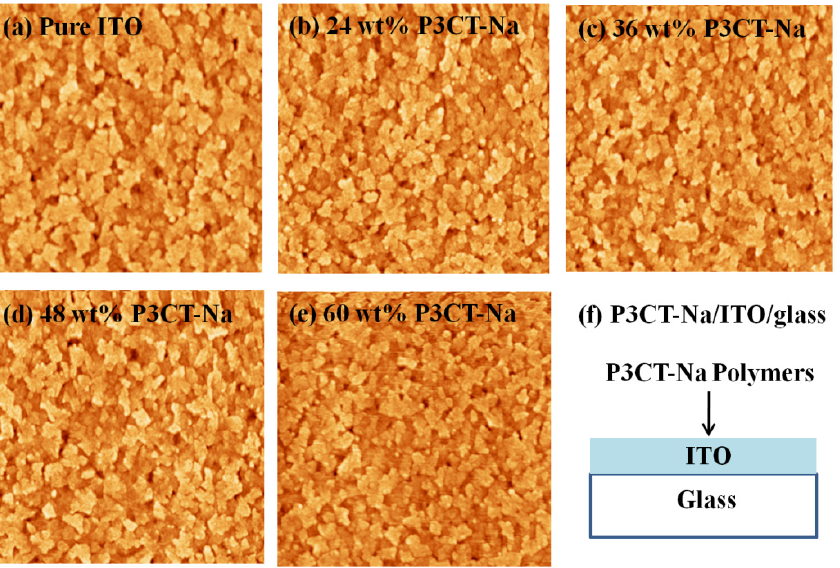
Figure 3. The atomic force microscopic images: ( a ) ITO/glass; ( b ) 24 wt% P3CT-Na/ITO/glass; ( c ) 36 wt% P3CT-Na/ITO/glass; ( d ) 48 wt% P3CT-Na/ITO/glass; ( e ) 60 wt% P3CT-Na/ITO/glass; ( f ) schematic diagram.